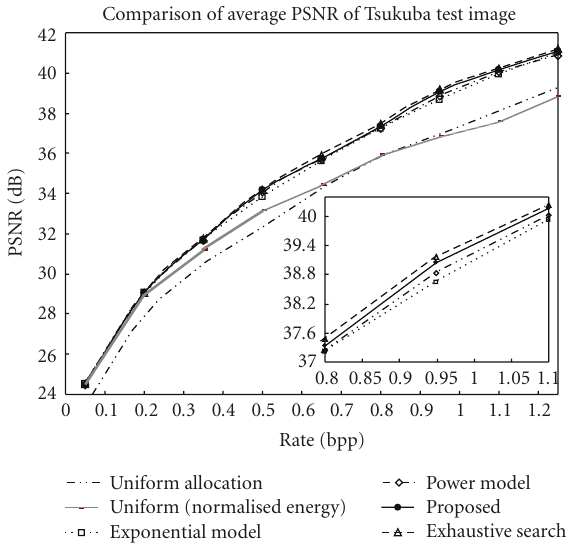
Figure 9: PSNR comparison of Tsukuba test image as in Figure 7 using method in [28].